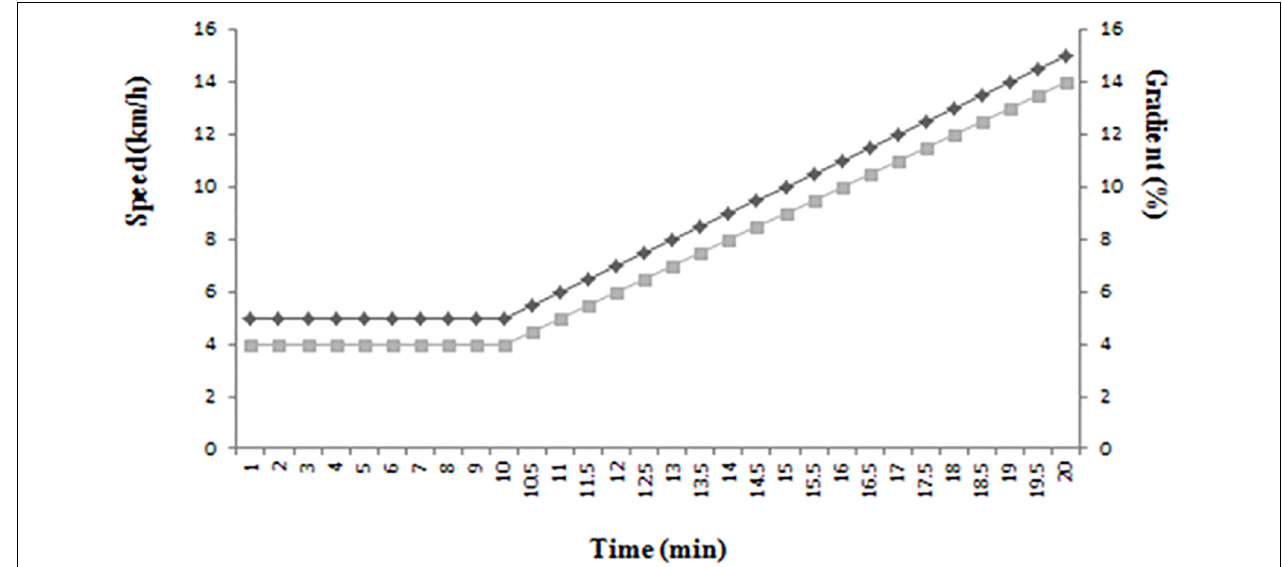
FIGURE 1 | Exercise test